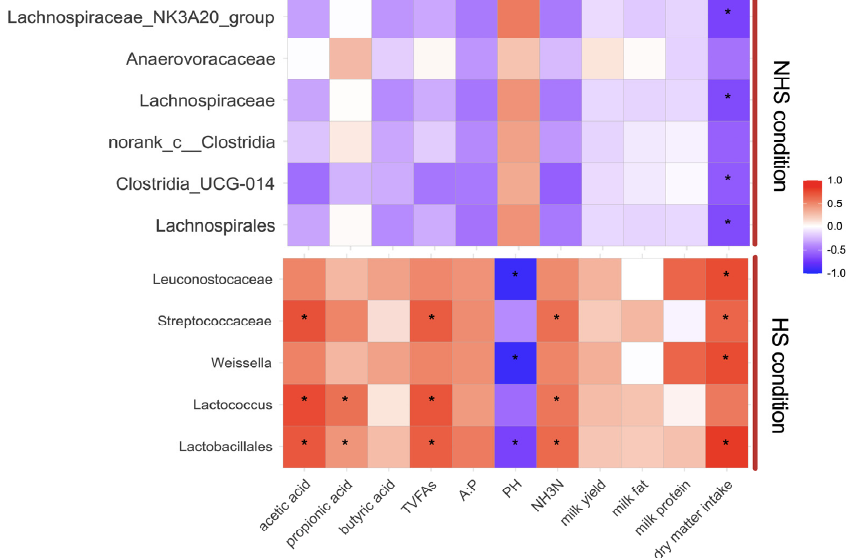
Figure 5. Effect of heat stress on correlation analysis between rumen bacteria and heat stress response indices including physiological and blood parameters, animal performance and rumen fermentation were assessed by Pearson correlation analyses. NHS, non-heat stress condition; HS, heat stress condition. Red indicates a positive correlation; the blue indicates a negative correlation; asterisks denote significant differences at p < 0.05.